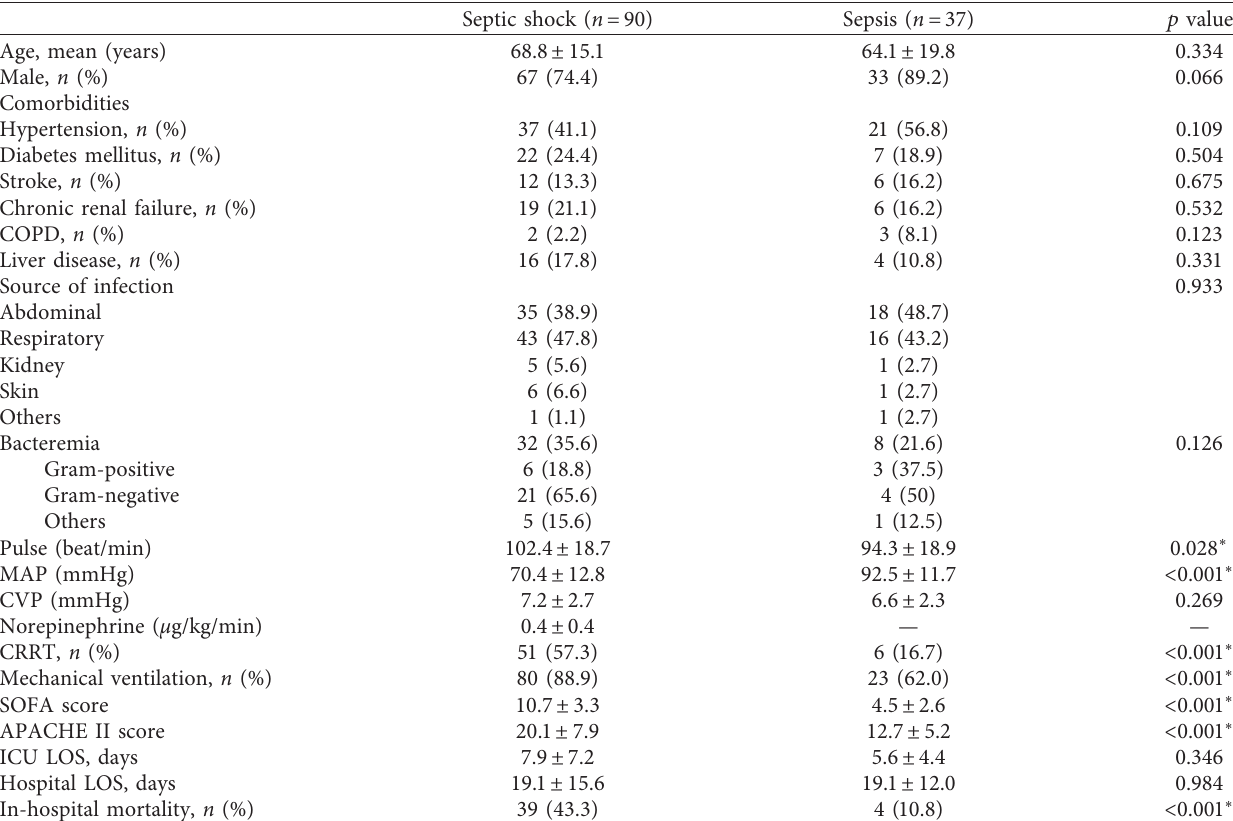
Figure 1: Inclusion/exclusion flowchart for study subjects. Table 1: Baseline characteristics and comparisons between patients with sepsis and those with septic